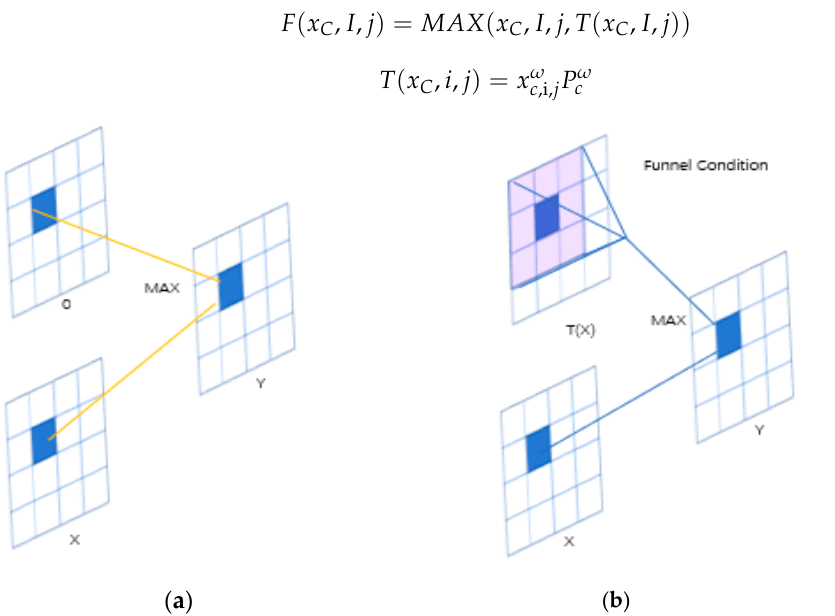
Figure 4. FReLU for visual recognition. ( a ) ReLU: MAX(X,0); ( b ) FReLU: MAX(X,T(X)).